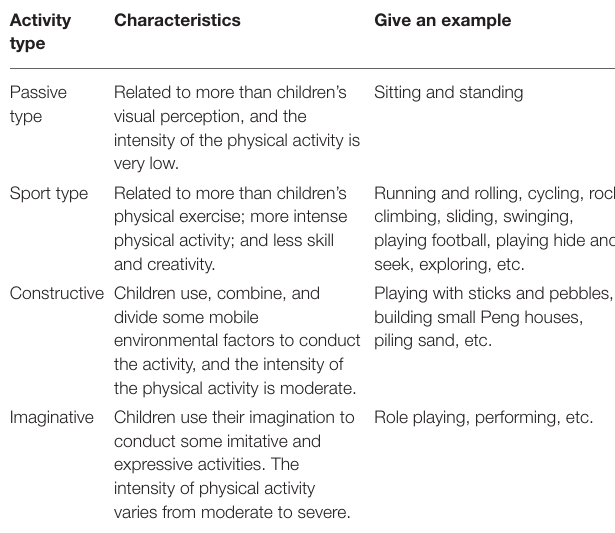
TABLE 6 | Correlation analysis of the types of children’s activities. TABLE 7 | Classification of children’s activity types by Fjørtoft.